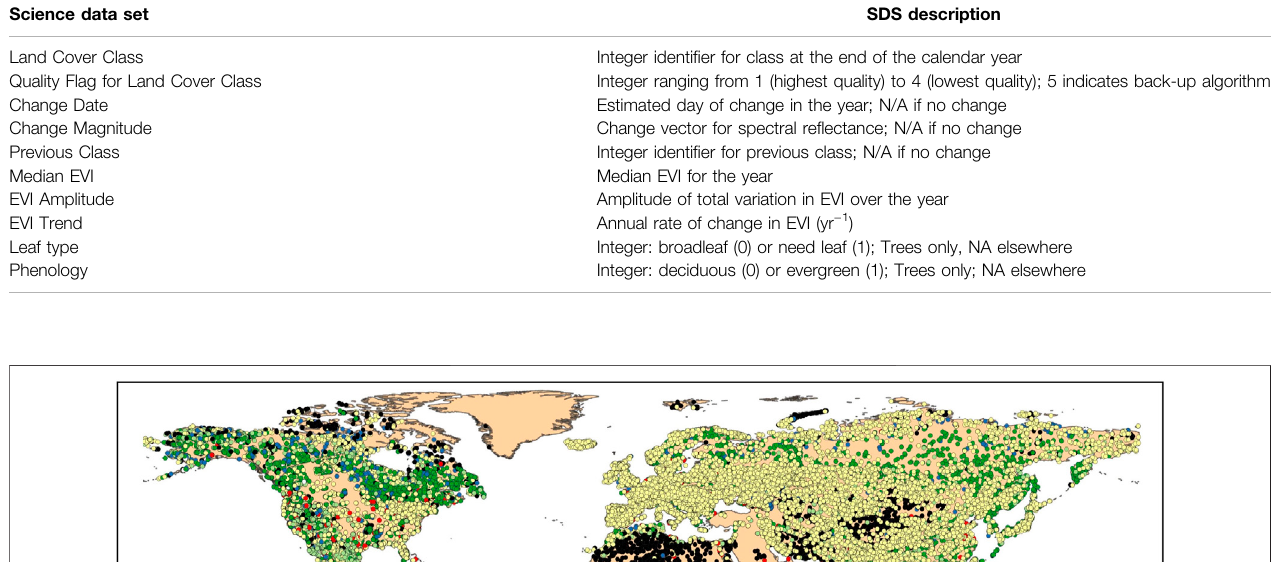
TABLE 3 | 30-m GLanCE Science Data Set Layers. The data will be distributed on the Land Processes DAAC in 150 km × 150 km tiles in the Albers equal area conic projection, and on Google Earth Engine. Science data set